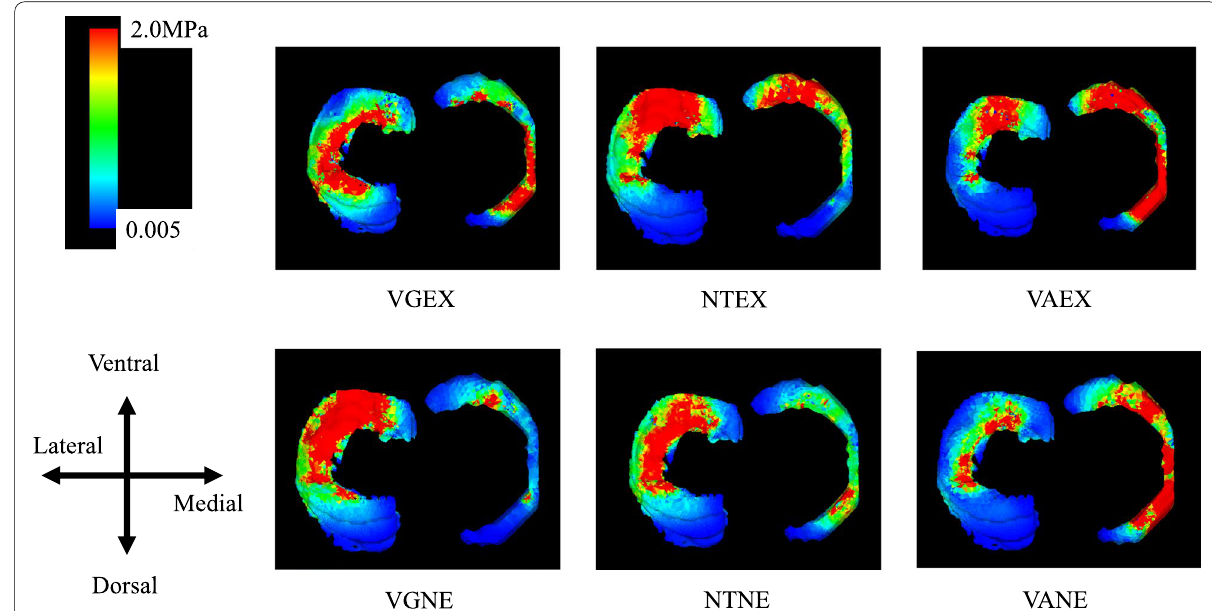
Fig. 5 Axial view of meniscus showing von Mises stress. The von Mises stress was most concentrated in the medial meniscus in the VAEX model, followed by the VANE. VGNE; valgus and non-extrusion of medial meniscus, VGEX; valgus and extrusion of medial meniscus; NTNE; neutral and non-extrusion of medial meniscus, NTEX; neutral and extrusion of medial meniscus, VANE; varus and non-extrusion of medial meniscus, VAEX; varus and extrusion of medial